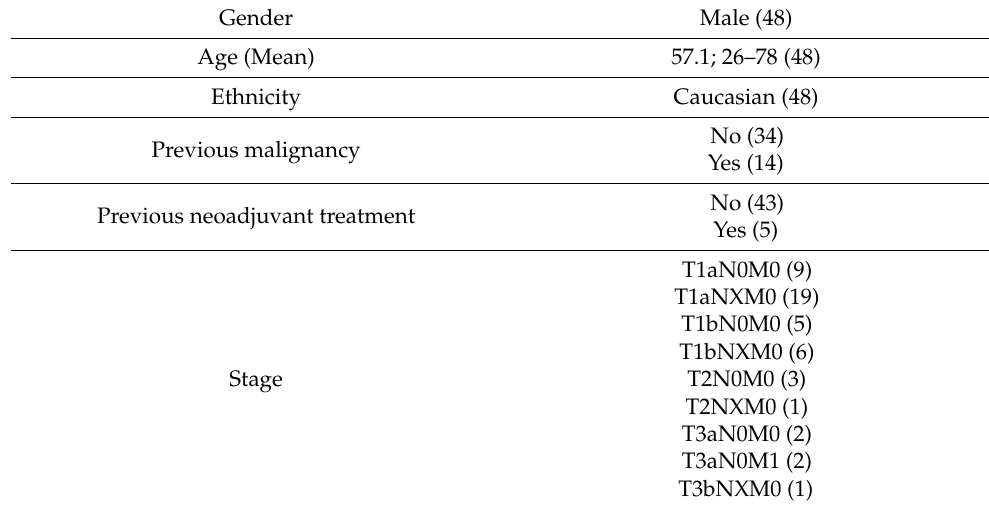
Table 1. Descriptive data of ccRCCa group.